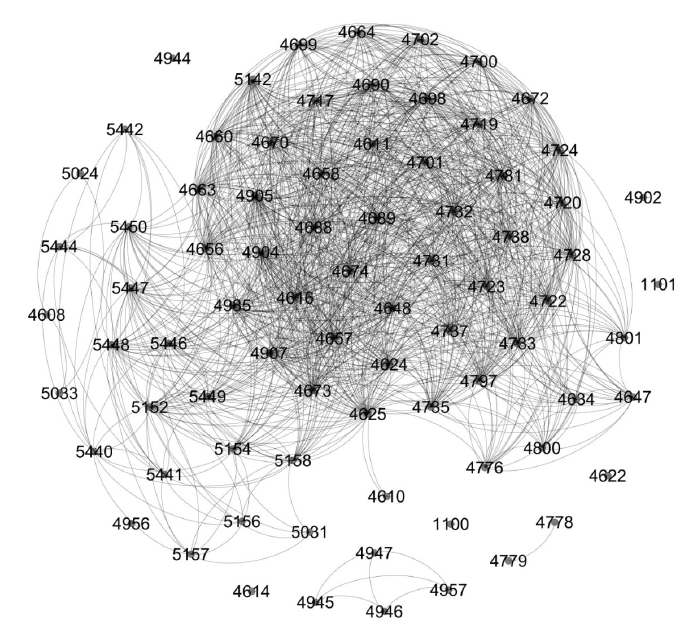
Figure 11. Fragment of the graph representing interconnections between the event characteristics (numbers represent event types).